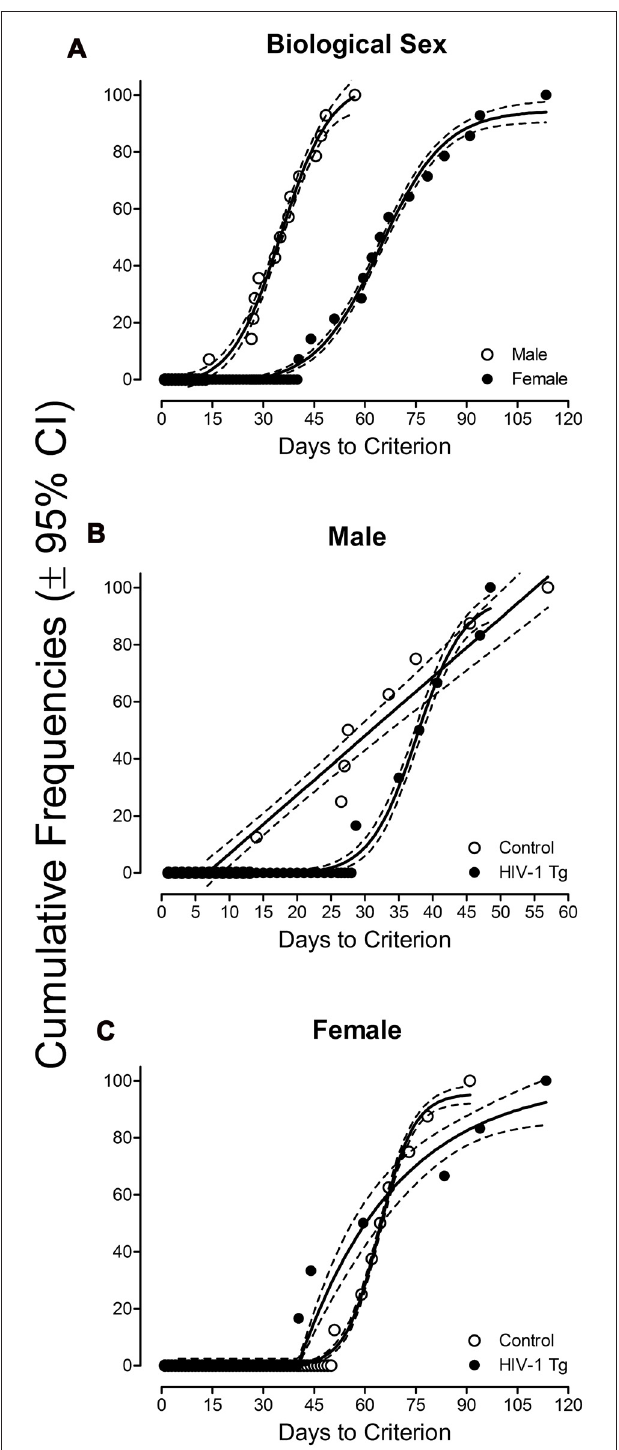
FIGURE 2 | (A) The number of sessions required to meet criterion (70% accuracy for five consecutive or seven non-consecutive days) in the signal detection task is presented as a function of biological sex, representing both HIV-1 Tg and control animals by collapsing across genotype ( ± 95% CI). A sigmoidal dose response was the best fit for both male ( R 2 : 0.99) and female